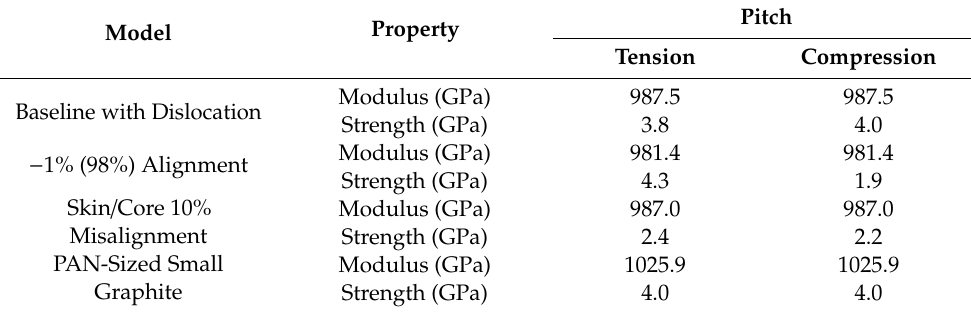
Table 5. Summary of modulus and strength results from Figure